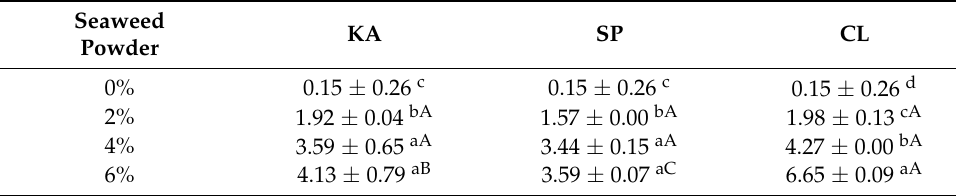
Table 7. Total phenolic content of all chicken sausage formulations. Seaweed